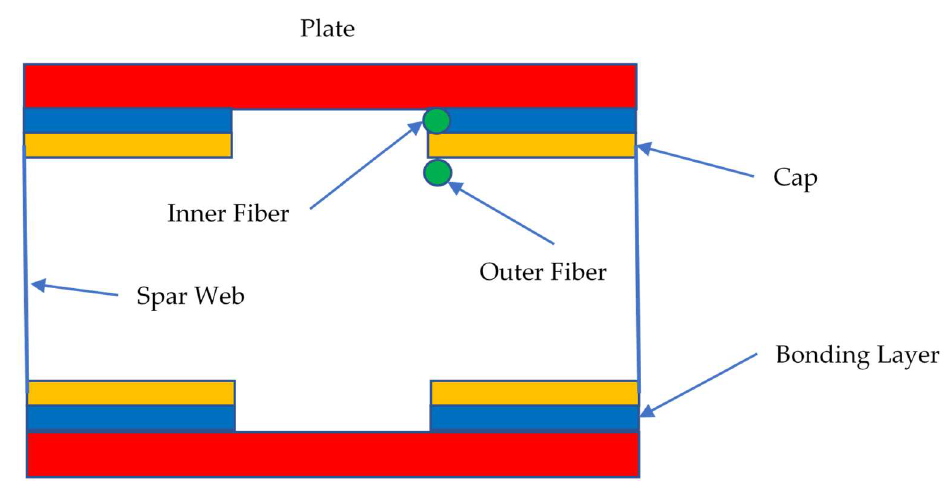
Figure 8. Pictorial view of the composite beam section; dimensions not to scale. Plane location of the strain acquisition lines, simulating a virtual, distributed fiber.